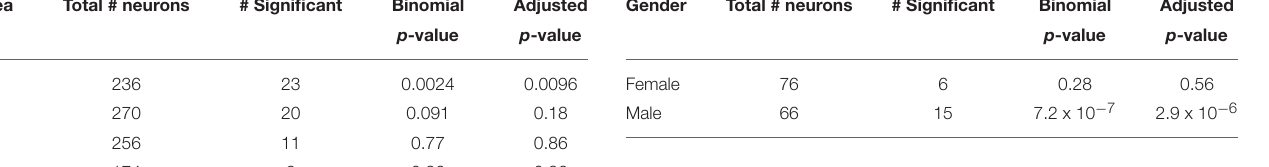
TABLE 4 | Neurons significant for emotion in right